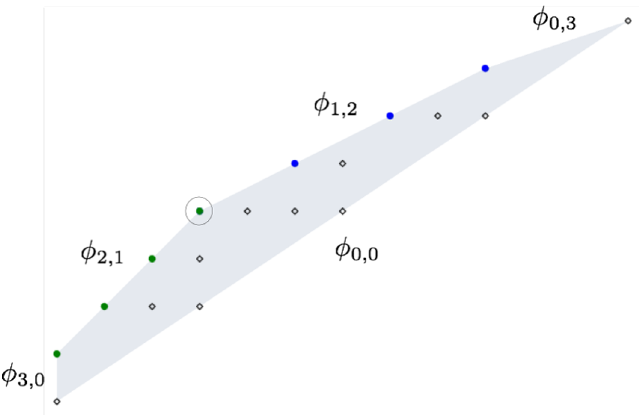
Figure 20 . Newton polygon and the initial forms (cid:30) p;q forming its edges for diag(2 ; 2 ; 2)